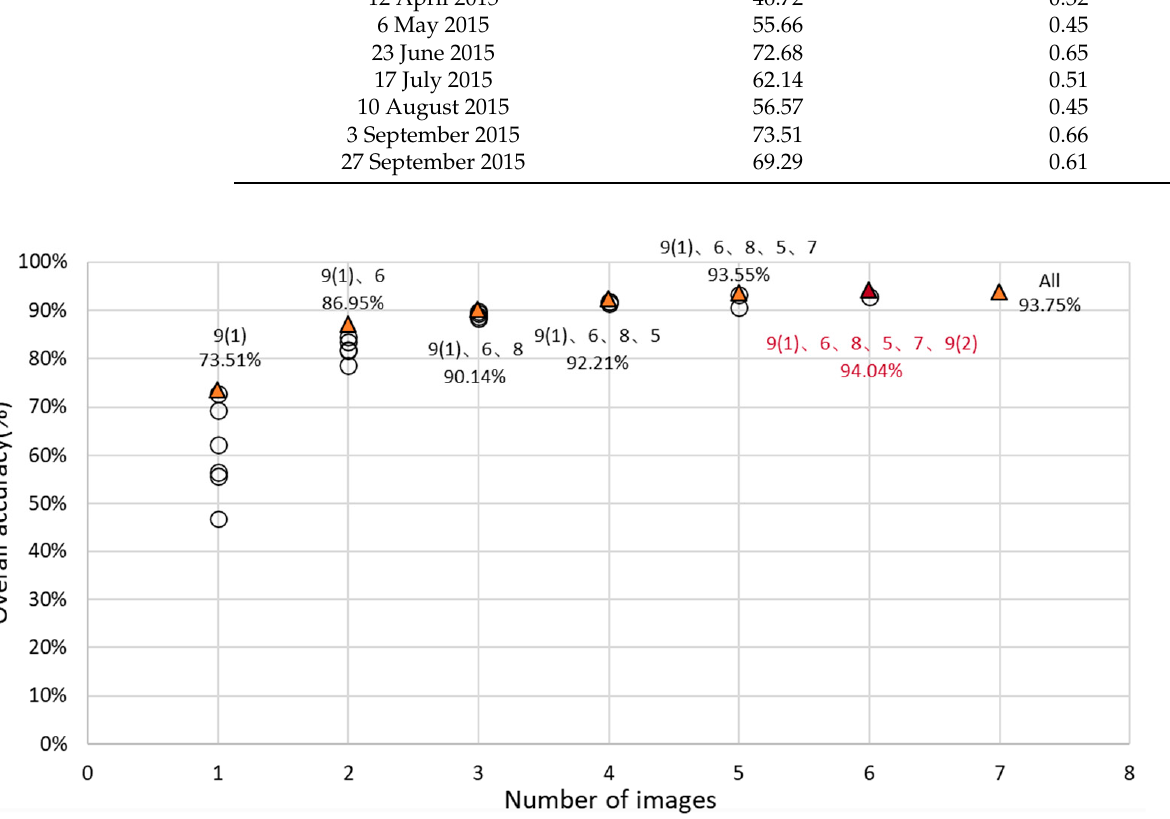
Figure 13. The RF overall accuracies for the optimal combination SAR image produced by a forward image selection procedure using optimal combination of polarimetric observables. Note that numbers in the figure denote the best accuracy in each step (at the bottom), and combinations of SAR images (at the top), for example “9(1), 6, 8, 5” represents the combination of images dated 3 September, 23 June, 10 August and 6 May (see Table 1).